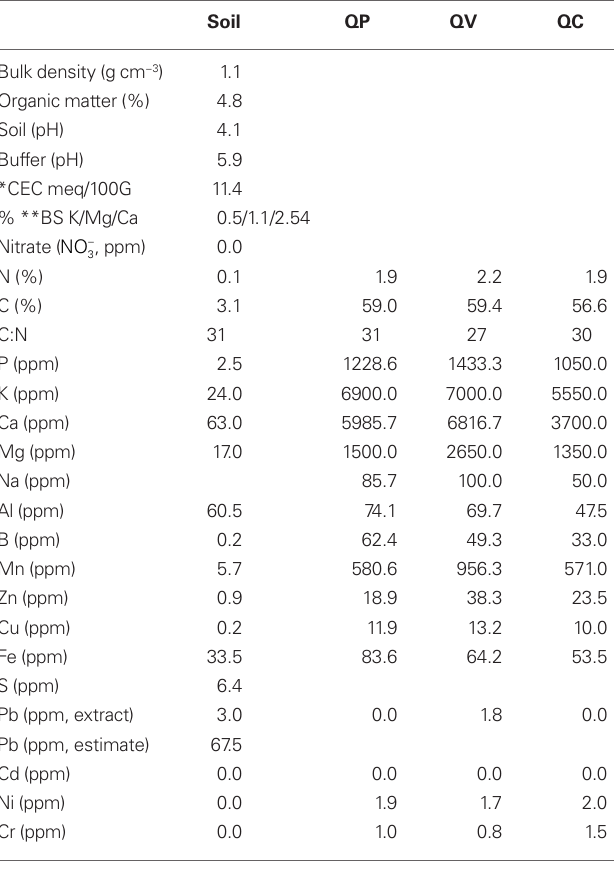
Table 1 | Soil of the upper horizon and leaf characteristics of the site